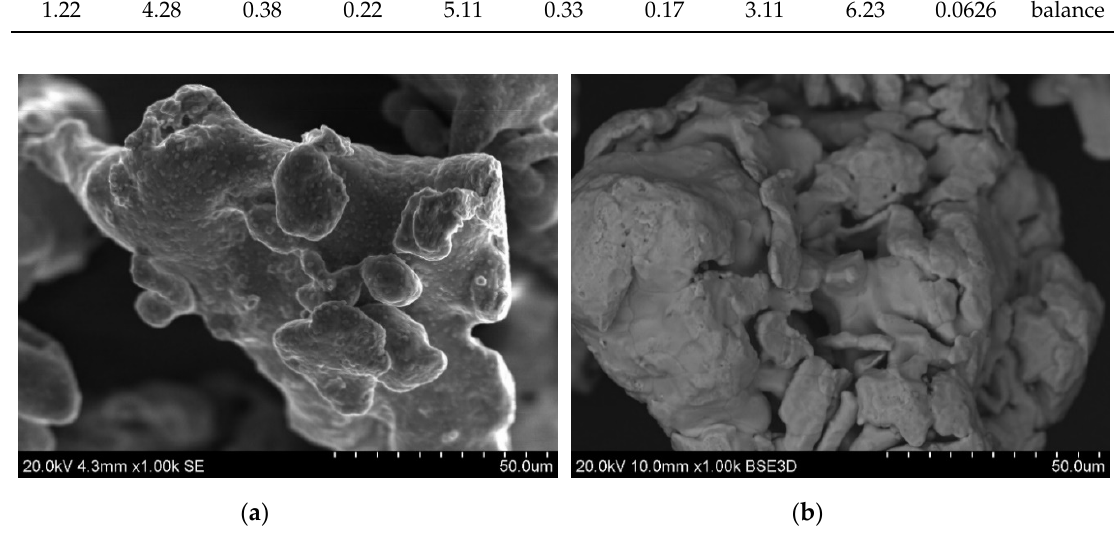
Figure 1. SEM morphologies of powders: ( a ) M3/2 high speed steel, ( b ) NC 100.24 iron; SEM.